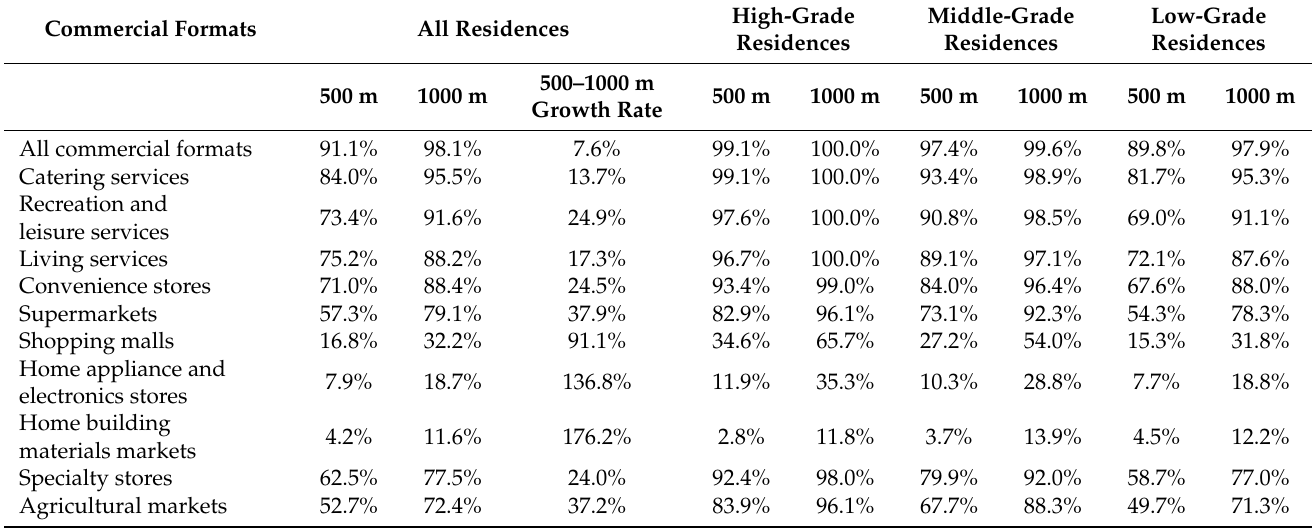
Table 5. The inclusion rate of commercial spaces based on honeycomb grids.